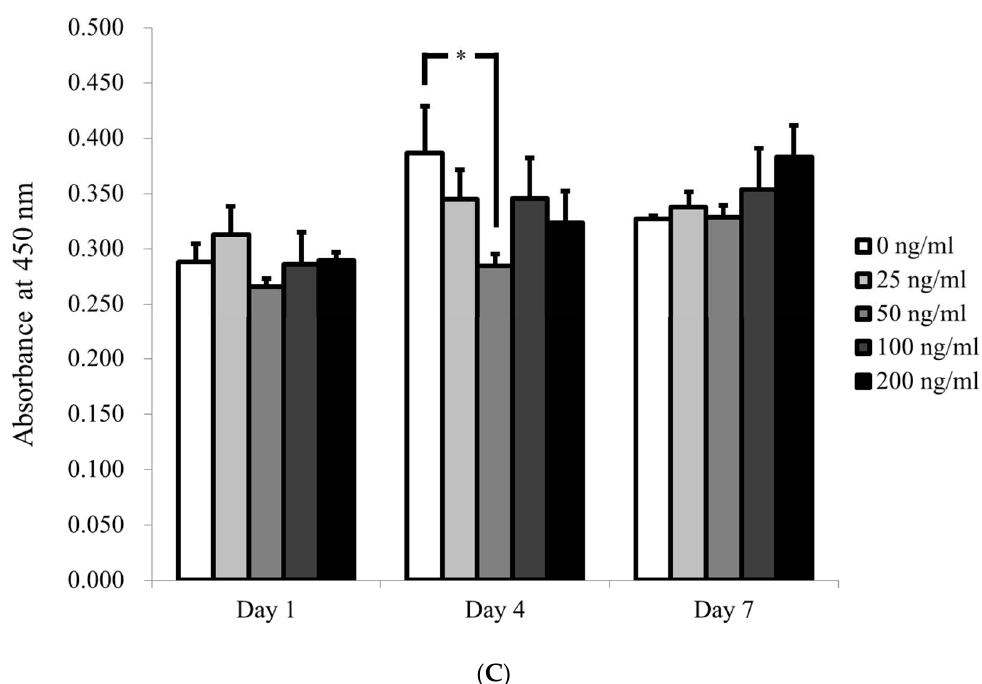
Figure 4. ( A ) Live, dead, and merged cell images of stem cell spheroids on Day 1. The scale bar represents 100 μ m (original magnification ×200). ( B ) Live, dead, and merged cell images of stem cell spheroids on Day 7 with the length of the scale of 100 μ m. ( C ) Cell viability using Cell Counting Kit-8 on Days 1, 4, and 7. * p < 0.05 vs. time-matched 0 ng/mL group.